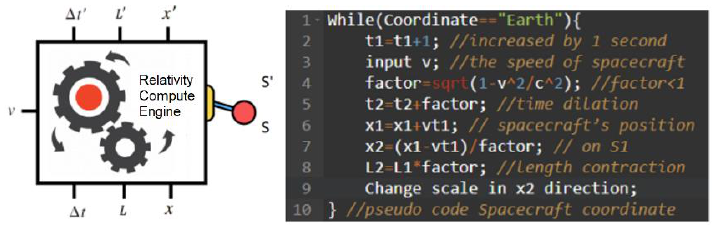
Figure 4. Relativity compute engine (switching to the Earth coordinate system).